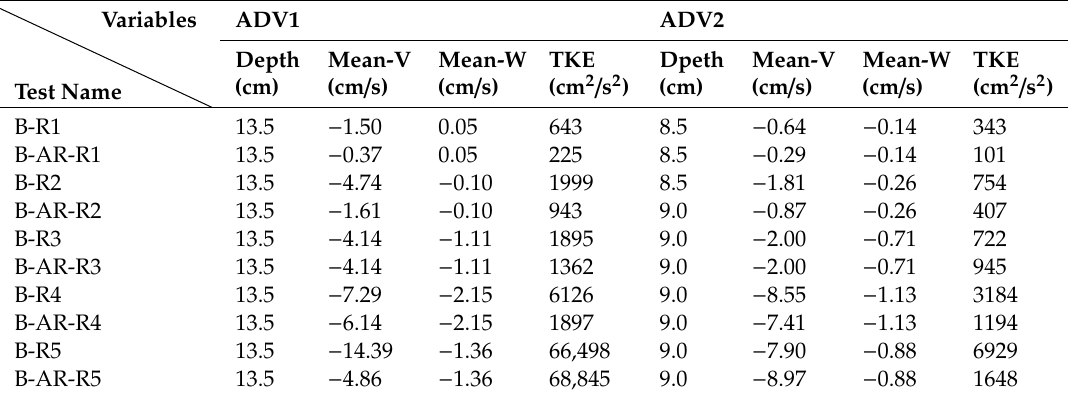
Table 2. Mean velocity and TKE at ADV1 (x = 6.1 m) and ADV2 (x = 7.0 m) under regular wave climates (depth is the distance between the probe and water